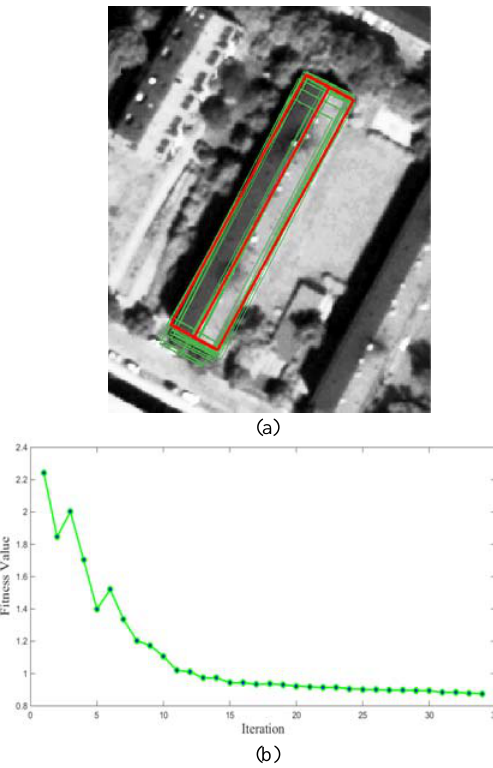
Figure 7. Statistical roof reconstruction: (a) search of optimum model (red) and (b) the convergence of cost function